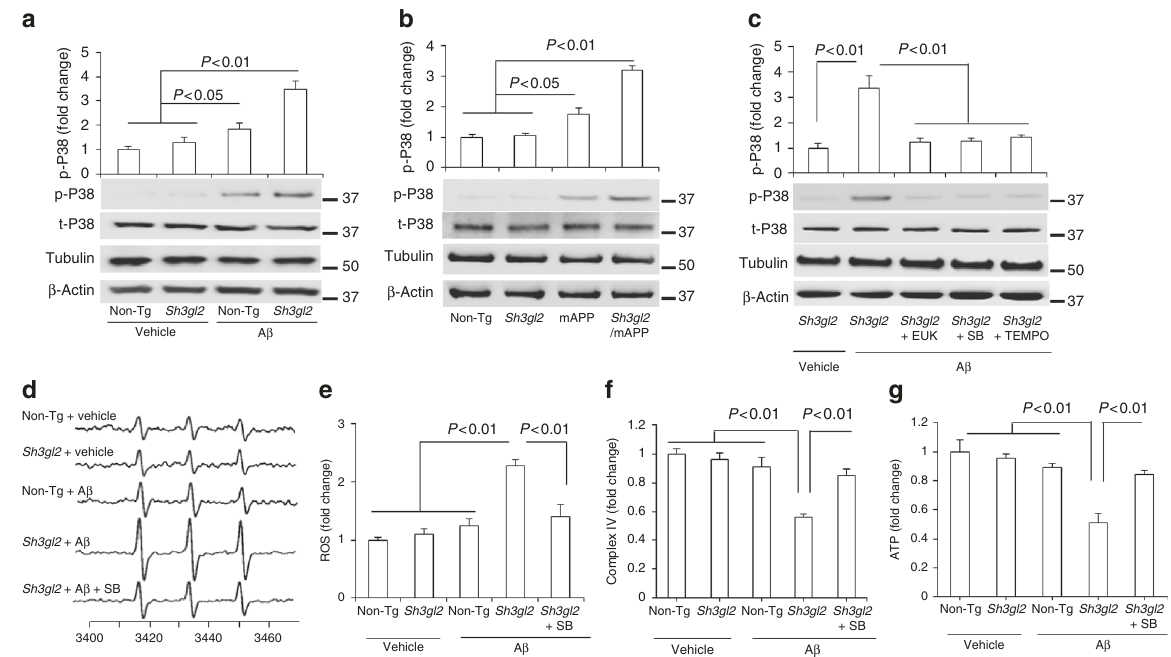
Fig. 4 Effect of EP overexpression on p38 MAP kinase activation and mitochondrial dysfunction in A β -insulted brain in vivo and brain slices in vitro. a Brain slices from 3-month-old non-Tg or Tg Sh3gl2 mice were perfused with A β (50 nM) or vehicle for 1 h and then subjected to immunoblotting analysis for the phosphorylation of p38 MAP kinase (p-p38), total p38 MAP kinase (t-p38), tubulin, and β -actin. Tubulin and β -actin served as a neuronal marker and protein loading controls, respectively. Data are expressed as fold change relative to the non-Tg vehicle control group. b Immunoblotting of cortical homogenates from the indicated Tg mice at 5 – 6 months of age for the indicated proteins. Data are expressed as fold change relative to the non-Tg mice group. c Brain slices from indicated Tg Sh3gl2 mice were treated with vehicle or A β (50 nM) with/without pretreatment of EUK-134 (EUK, 500 nM), SB203580 (SB, 1 µ M), or mitochondrial antioxidant MitoTEMPO (TEMPO, 1 µ M) for 5 min, and then subjected to immunoblotting for the phosphorylation of p38 MAP kinase (p-P38), total p38 MAP kinase (t-p38), tubulin, and β -actin. Data are expressed as fold change relative to the Tg Sh3gl2 vehicle control group. Date are shown as mean ± s.e.m., n = 3 per group (one-way ANOVA in a – c ). d Representative spectra of EPR in non-Tg and Tg Sh3gl2 brain slices with the treatment of vehicle or A β (50 nM) in the presence of SB203580 (1 µ M). e Quanti fi cation of EPR spectra in the indicated groups of mice. f – g Mitochondrial complex IV activity ( f ) and ATP levels ( g ) in the indicated groups of brain slices treated with vehicle or A β in the presence/absence of SB203580. Data are expressed as fold increase relative to non-Tg vehicle control group. Date are shown as mean ± s.e.m., n = 3 per group (one-way ANOVA in e – g